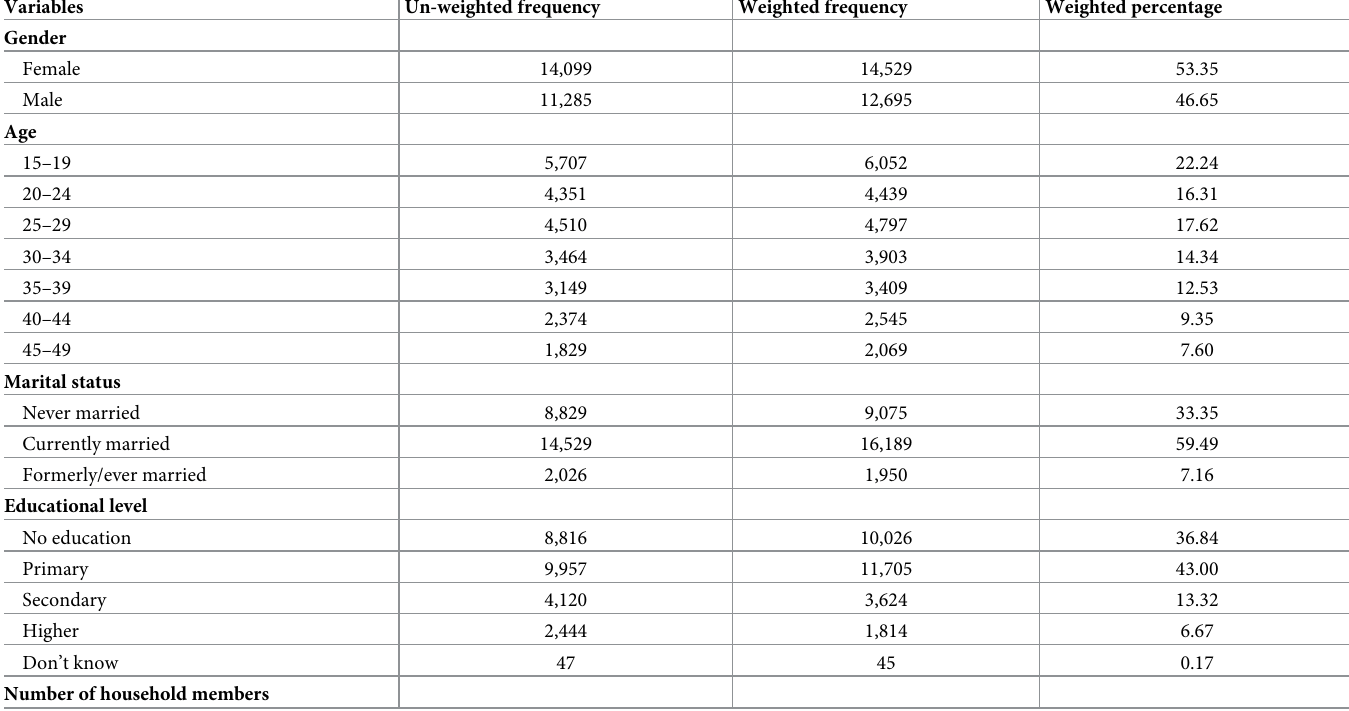
Table 2. Characteristics of respondents in Ethiopia from January 18 to June 27,